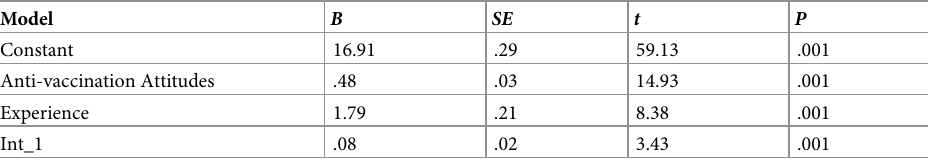
Table 4. Summary of the results of the moderation effect.